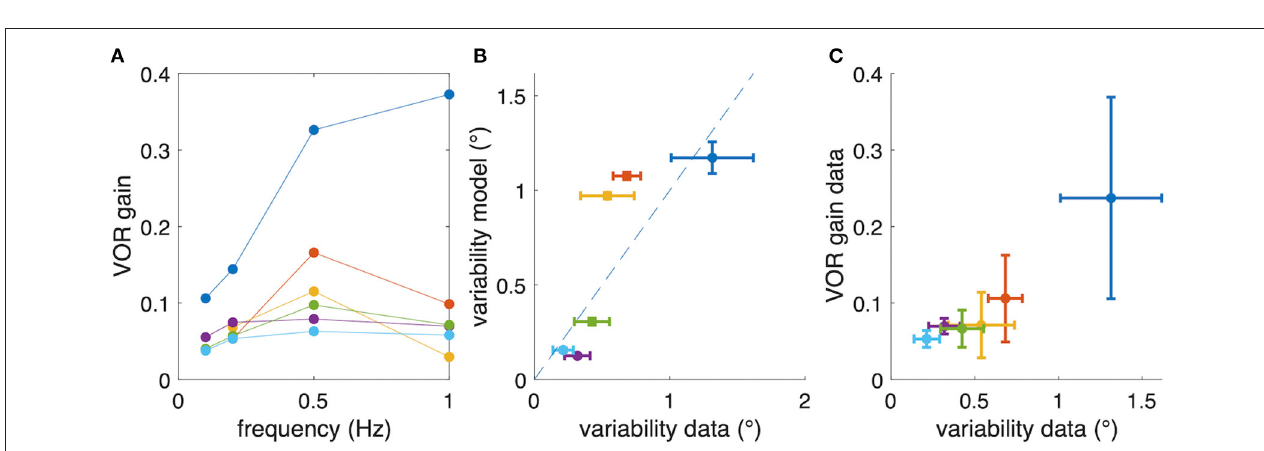
FIGURE 6 | Relation between aVOR gain and variability of eye movements. (A) For comparison, aVOR gain values (see Figure 2 ) are shown for each animal separately in different colors. (B) Variability of eye movements for each animal plotted with respect to the predicted variability, i.e., the variability of the model simulations. (C) Variability of eye movements for each animal plotted with respect to the aVOR gain. Each data point in (B,C) represents the mean across four stimulus frequencies; error bars denote the standard deviation; note that for the animals depicted in yellow and orange only data for three frequencies were